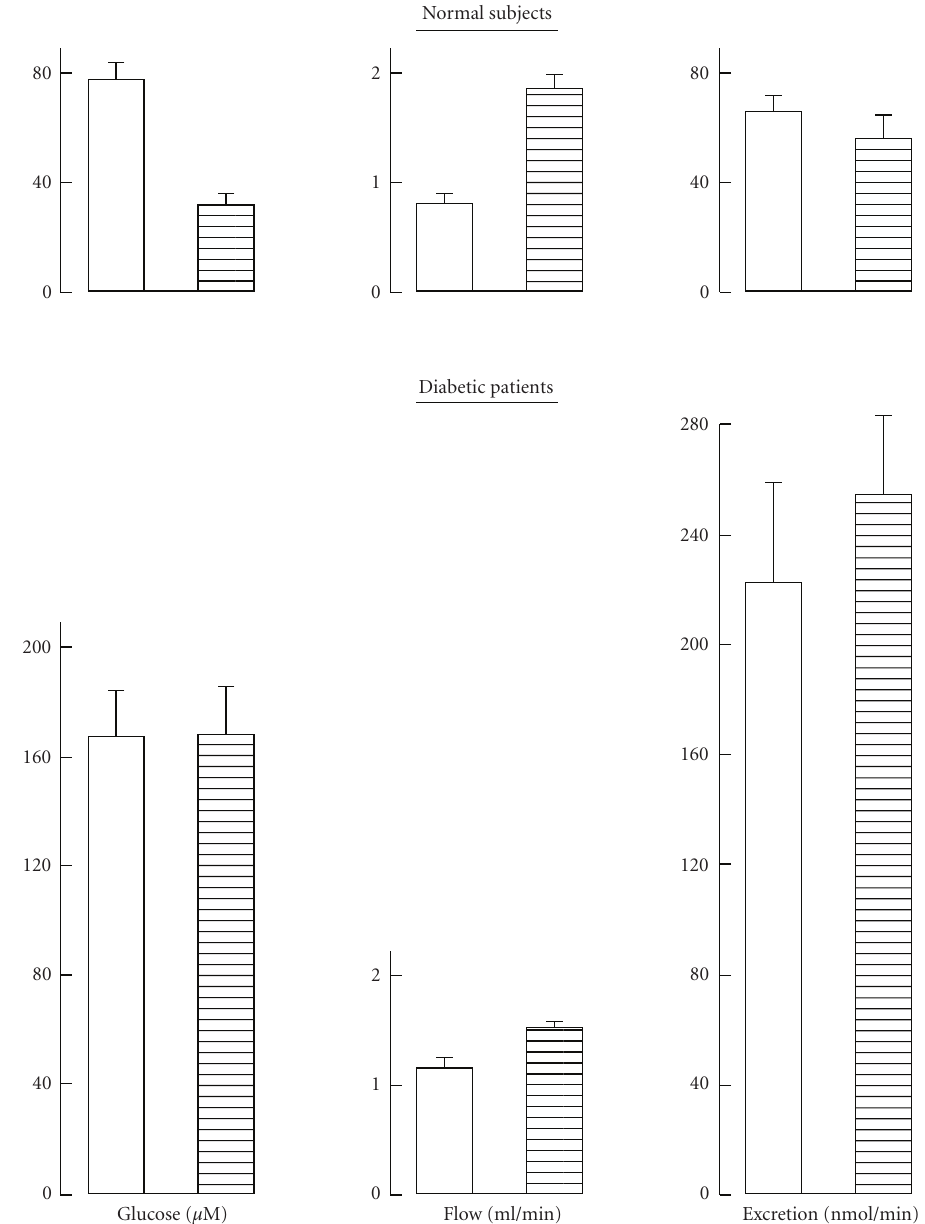
Figure 3: Glucose concentration, salivary flow, and glucose excretion rate for unstimulated (open columns) and stimulated (hatched columns) saliva in normal subjects and diabetic patients. Mean values ( ± SEM) are derived from all data collected in the present study and, hence, refer to 33–101 individual